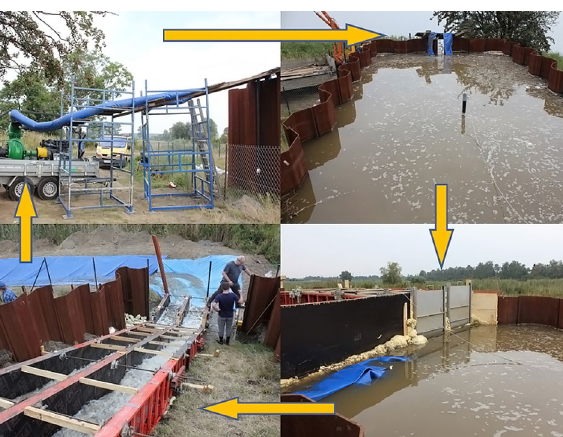
Fig. 6. Water cycle for the overflowing tests: pump, reservoir, shutters and flumes